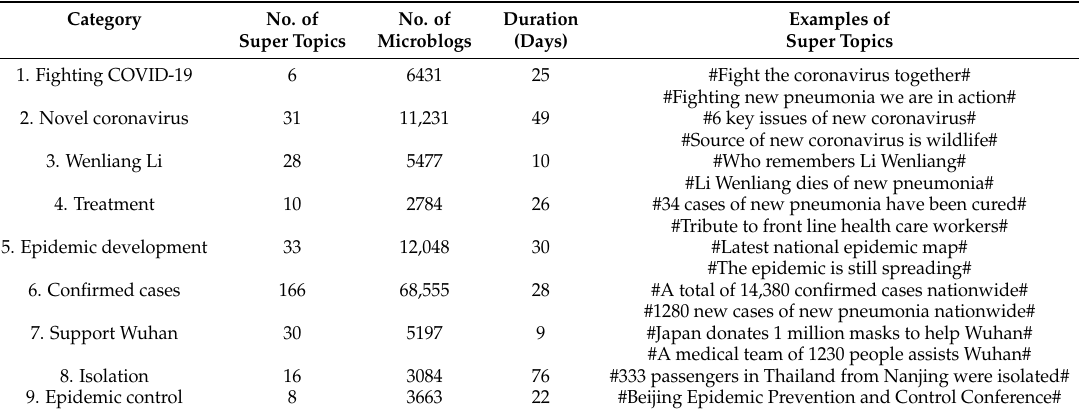
Table 3. Characteristics of nine super topic categories and